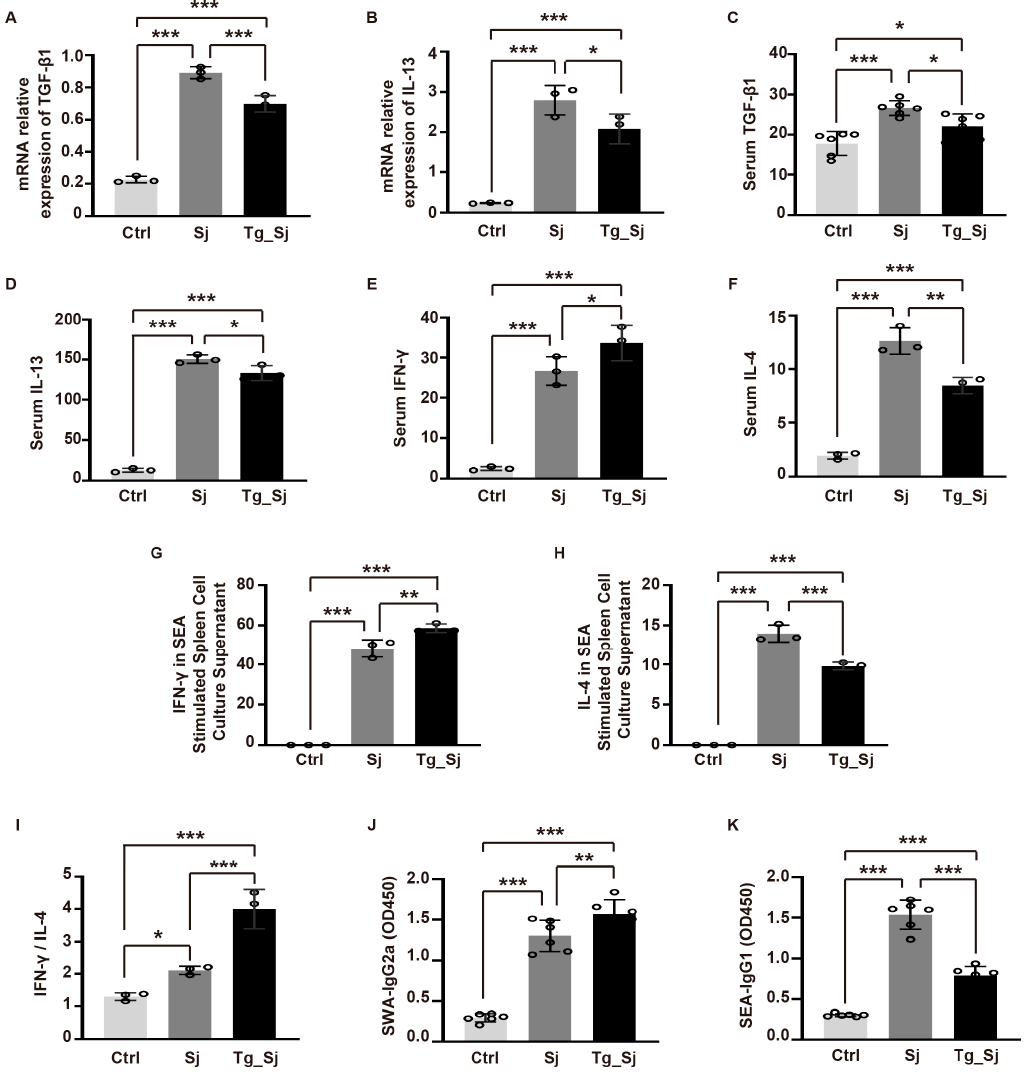
Figure 3. Co-infection inhibits S. japonicum mediated Th2 immune response. ( A , B ) The mRNA levels of TGF- β 1, IL-13 in liver tissues were determined using real-time PCR. Data are normalized to GAPDH and expressed as arbitrary units. ( C , D , E , F ) The serum levels of TGF- β 1, IL-13, IFN- γ and IL-4 were determined by ELISA. ( G , H ) IFN- γ and IL-4 levels in cultured supernatants from SEA-stimulated spleen cells were determined by ELISA. ( I ) The ratio between IFN- γ and IL-4 levels. ( J ) SWA-IgG2a and ( K ) SEA-IgG1 levels was detected by ELISA. Results are representative of at least three independent experiments ( A , B , D – I , n = 3, C , J , K , n = 6, one-way ANOVA). * p < 0.05, ** p < 0.01, *** p < 0.001.